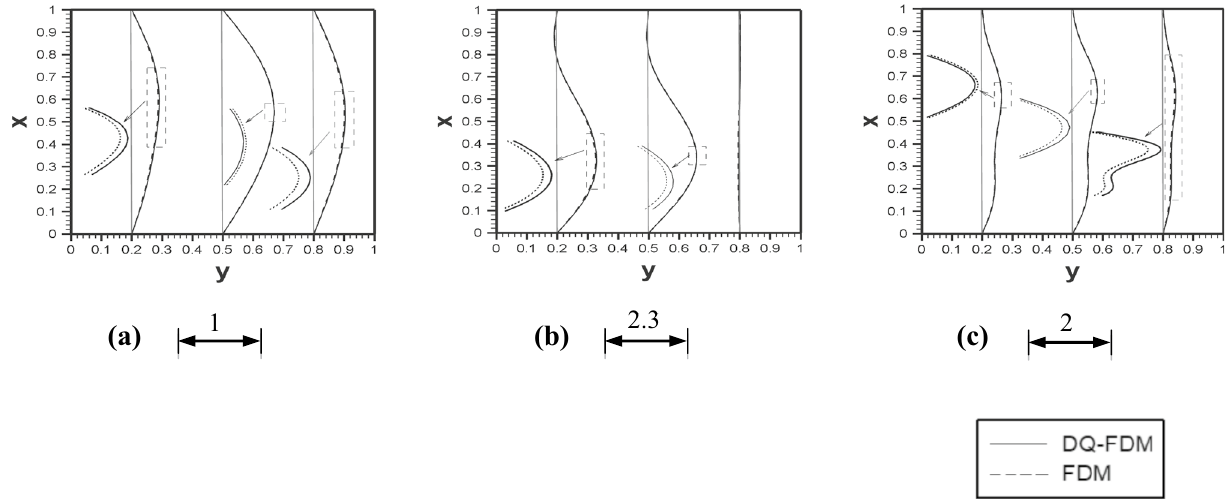
Fig. 8 A sample of comparing the distribution of the velocity of the a longitudinal ( u ), b depth ( v ) and c transverse ( w ) along the length and for passing plate through the middle of the width (t = 0.05,